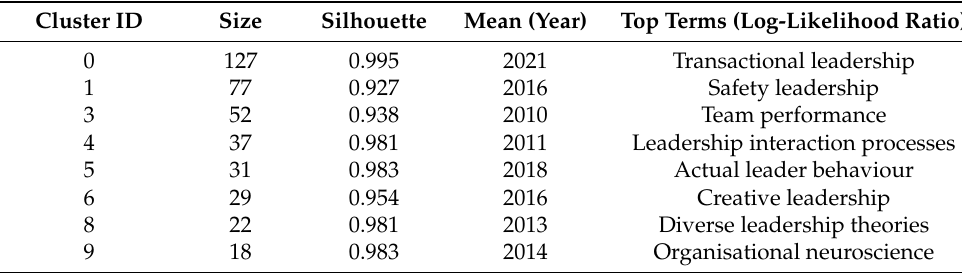
Table 6. Top eight co-citation